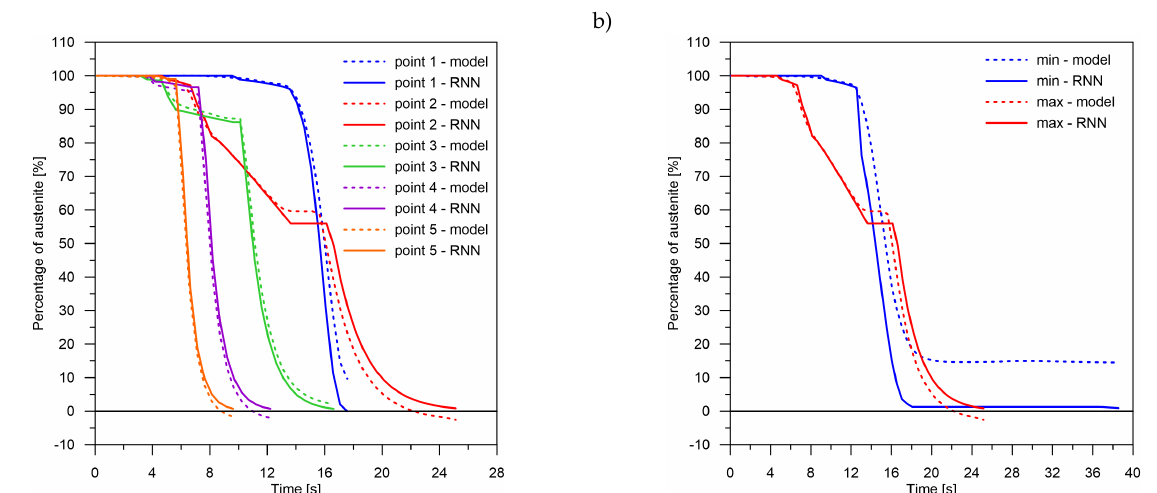
Figure 9. Kinetics of transformations: a comparison of the analytical model with the RNN model for case No. 2.